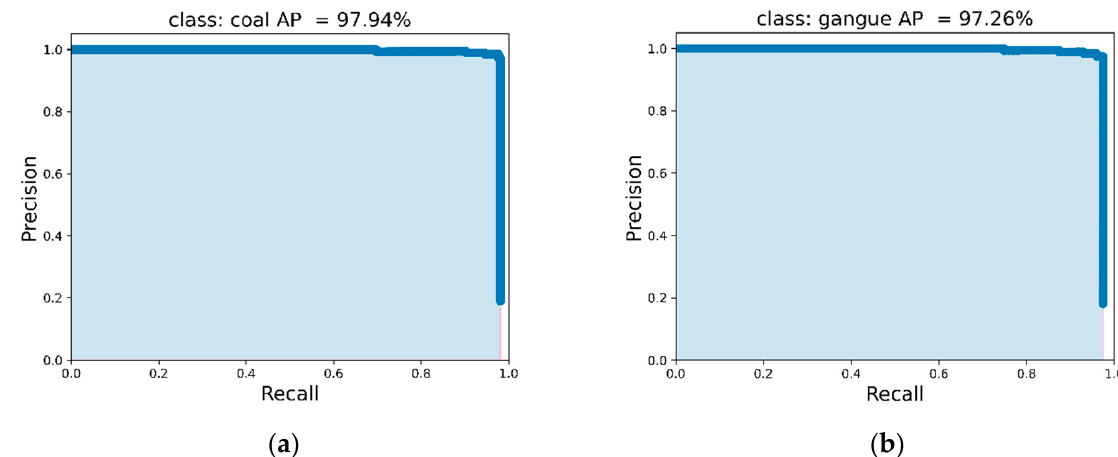
Figure 13. P–R curve of coal and gauge: ( a ) P–R curve of coal; ( b ) P–R curve of gauge.